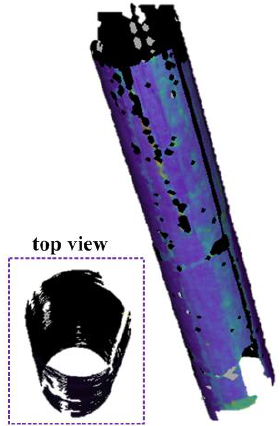
Figure 19. 3D shape of the circular column [51].